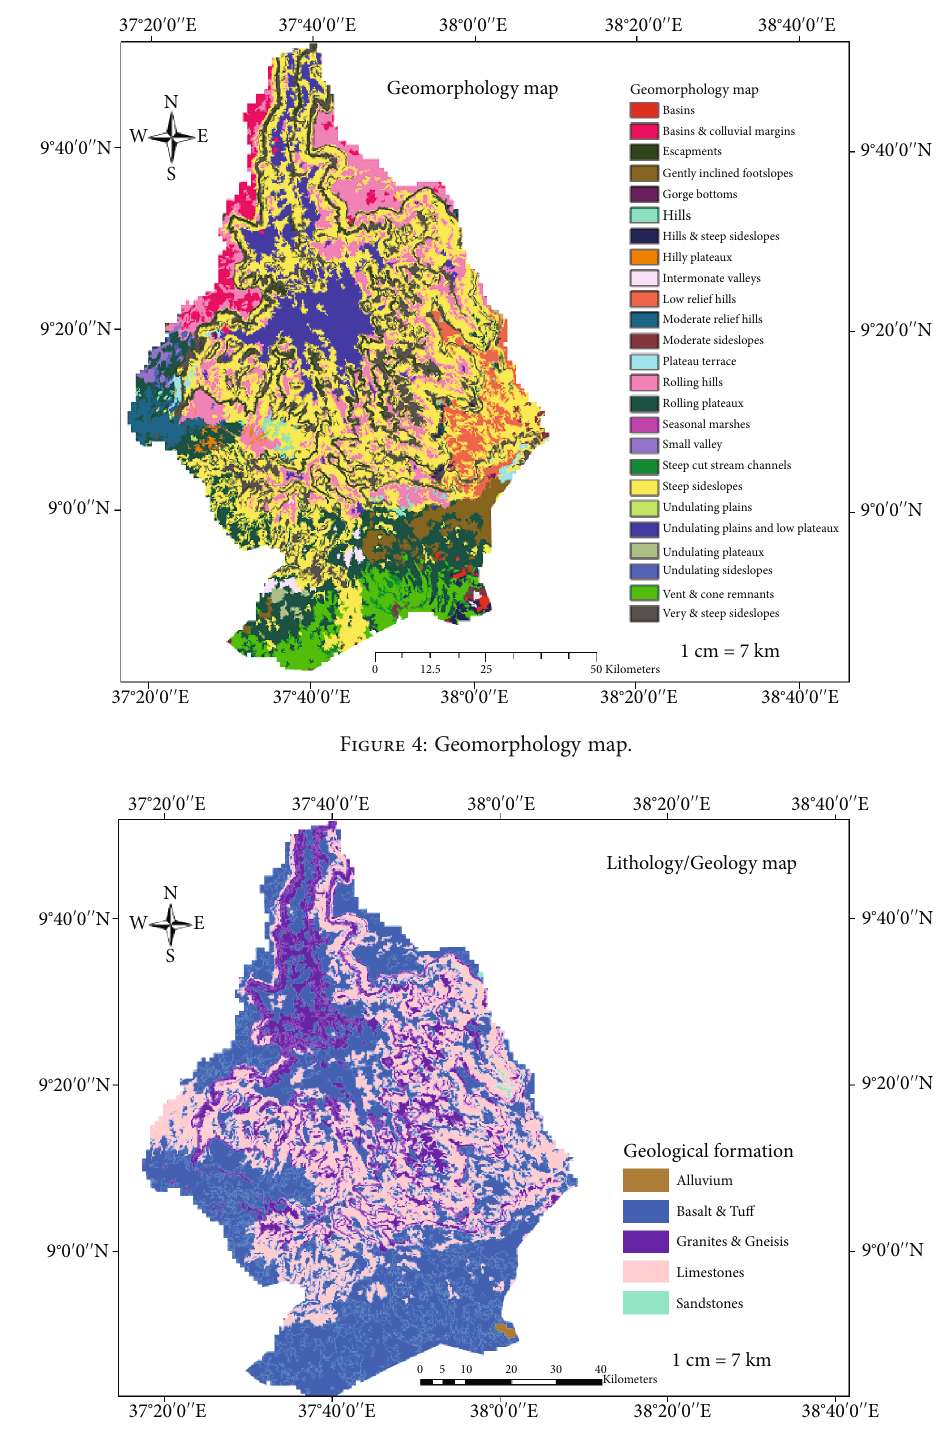
Figure 5: Geological map of the study